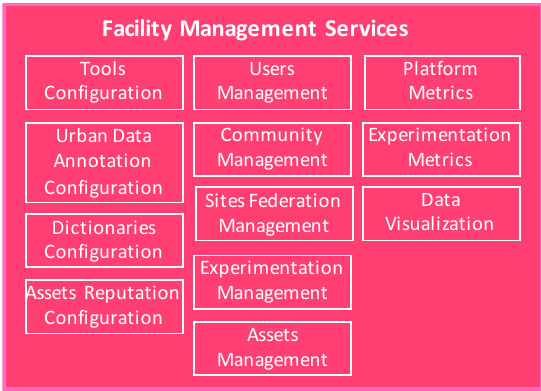
Figure 3. Facility management framework.